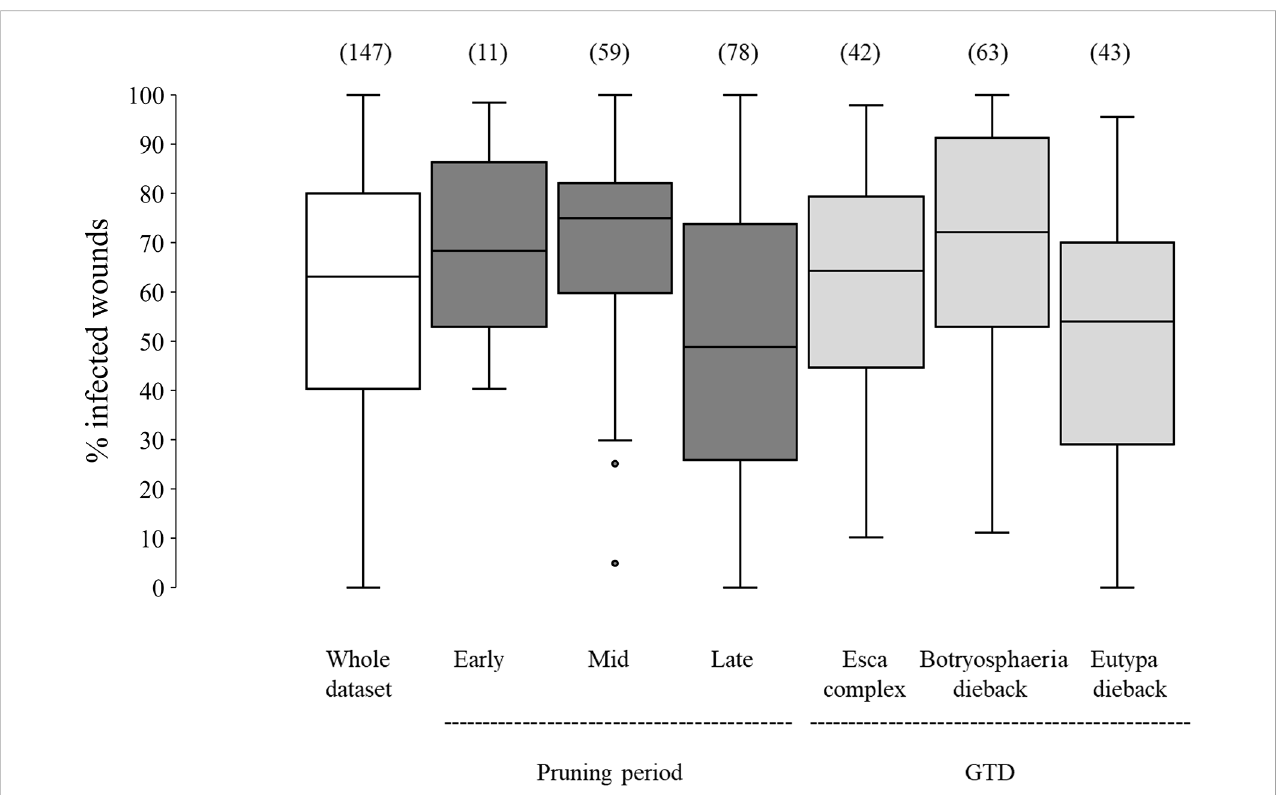
FIGURE 2 Susceptibility of the pruning wounds at the time of pruning (t 0 ) (expressed as the % of the wounds that became infected after being arti fi cially inoculated with fungi associated with grape trunk diseases [GTDs] for the whole dataset (the white box), and for subsets of data concerning pruning periods (the dark-grey boxes) and GTDs (the light-grey boxes). The values in brackets indicate the number of observations available for each subset. Whiskers indicate the lowest and highest values (excluding outliers, represented by black dots); 25% of the data fall below the lower quartile value, and 75% of the data fall below the upper quartile value. The median marks the mid-point of the data and is shown by the line that divides the box into two